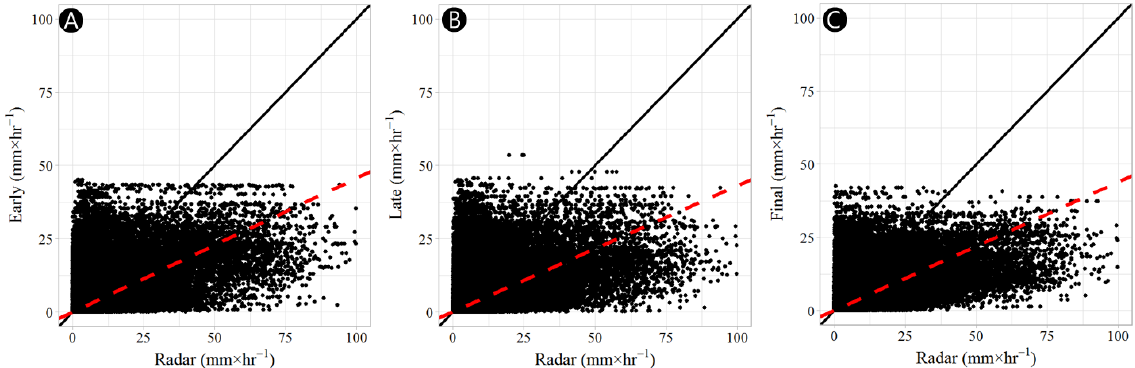
Figure 6. Scatterplot of IMERG ( A ) Early-, ( B ) Late-, and ( C ) Final-run products, and Stage-IV average hourly precipitation data from 14 to 21 September 2019.